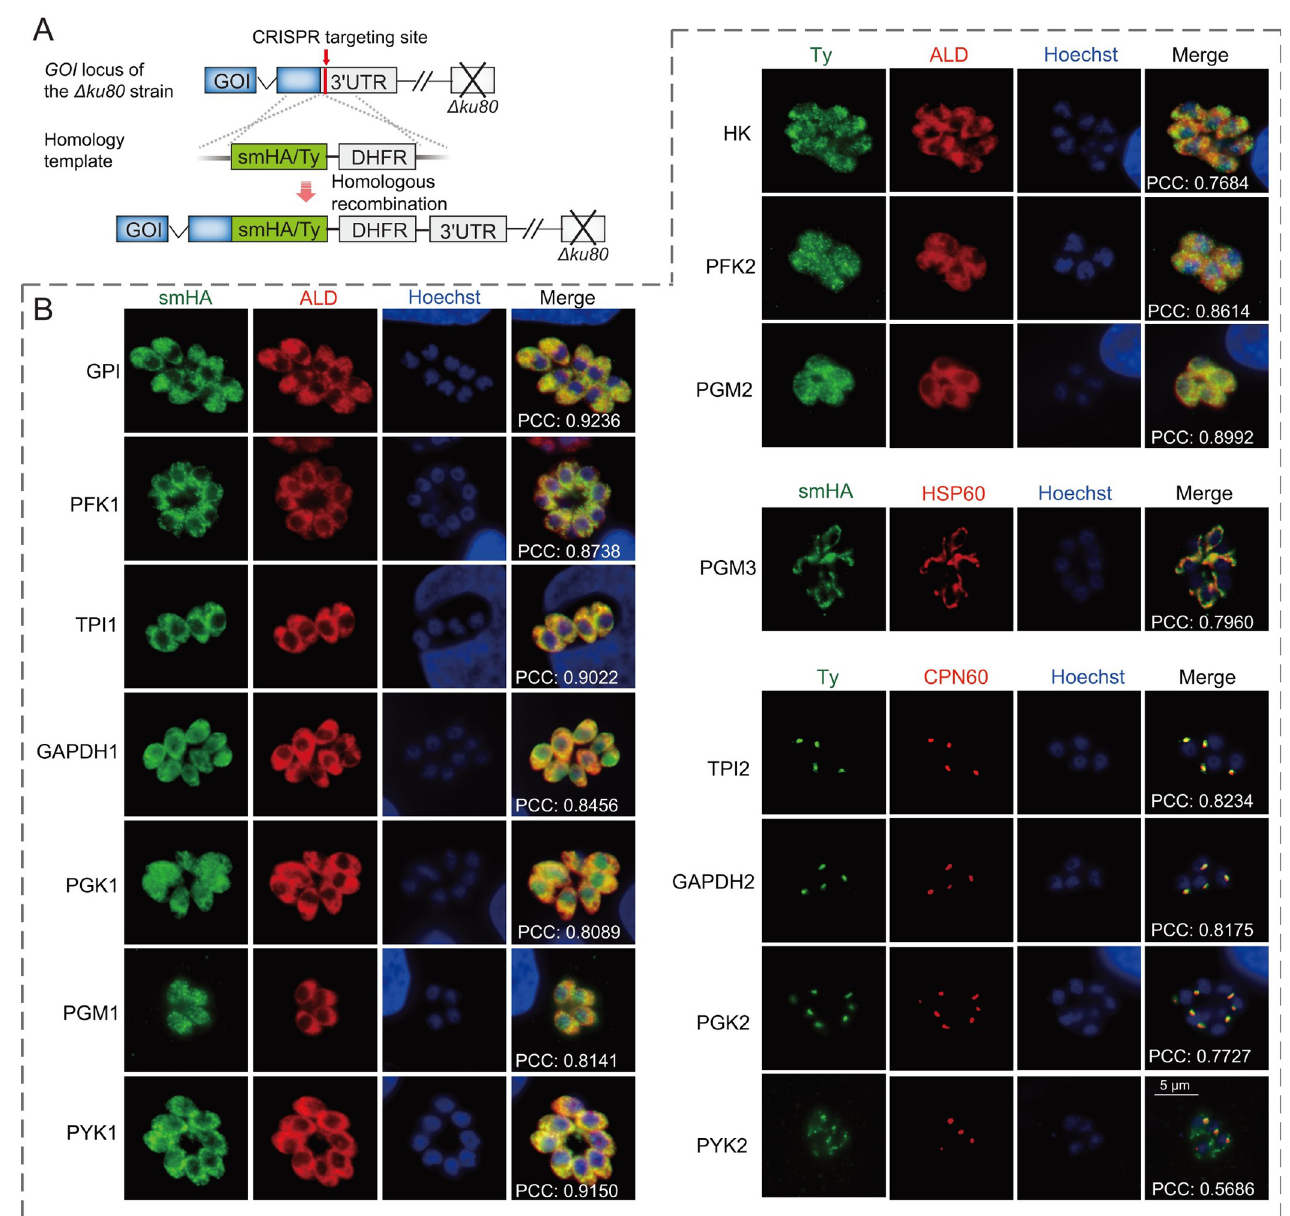
Fig 1. Subcellular localization patterns of glycolytic isoenzymes in T . gondii tachyzoites. A, strategy for C terminal tagging of a gene of interest (GOI) with an smHA or Ty tag at the endogenous locus, through CRISPR/Cas9 mediated site specific integration in the Δ ku80 strain. DHFR is the selection marker that confers pyrimethamine resistance. B, Subcellular localization of selected glycolytic isoenzymes, determined by immunofluorescent staining of corresponding tagged strains generated in A. ALD, HSP60 and CPN60 were used as cytosol, mitochondrion, and apicoplast specific markers, respectively. The degree of co- localization between tagged proteins and organelle specific markers were quantified by Pearson’s correlation and expressed as Pearson correlation coefficient (PCC).